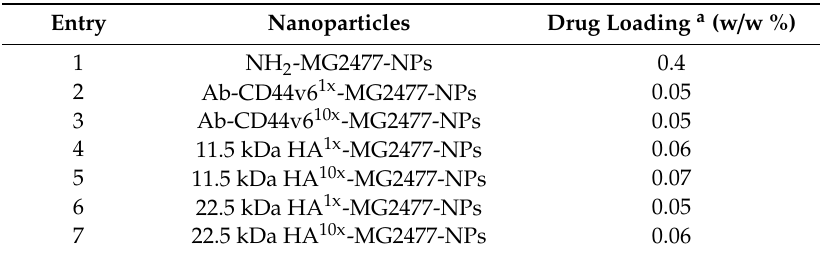
Table 2. Loading of anti-cancer drug into unconjugated and conjugated